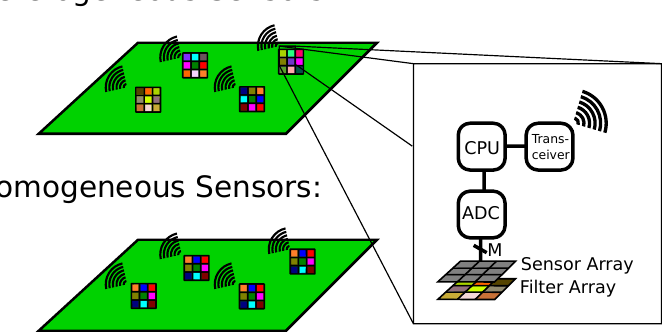
Figure 1. Architecture of an M2HSN with a heterogeneous and homogeneous choice of